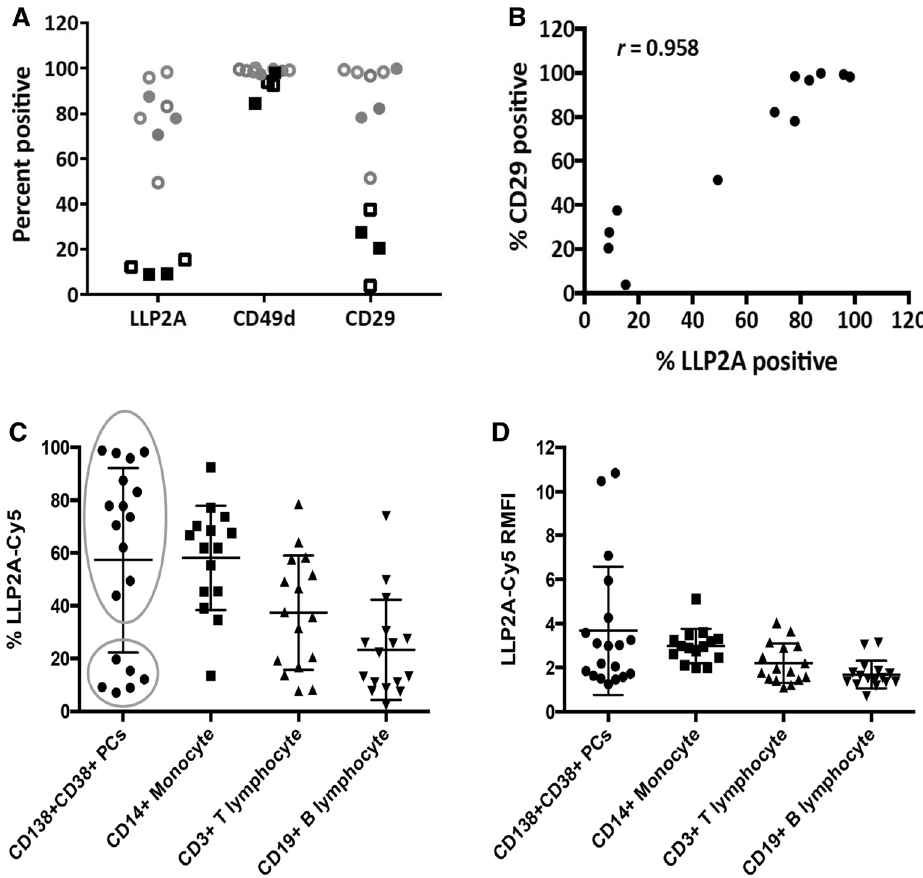
Figure 6. LLP2A-Cy5 reports on expression of dimeric VLA4 in primary human multiple myeloma. ( A ) Percentage of LLP2A + , CD49d + ( α 4 ) and CD29 + ( β 1 ) on CD138 + CD38 + cells from 12 MM BM patient samples. Dense and open symbols referred to newly diagnosed and relapsed patient samples, respectively. ( B ) The correlation between percentage of LLP2A + cells and CD29 + cells [Pearson correlation coefficient with r = 0.958 ( p < 0.0001)]. ( C ) The percentage of LLP2A + cells and ( D ) relative mean fluorescent intensity (RMFI) on different cell types (19 MM PC